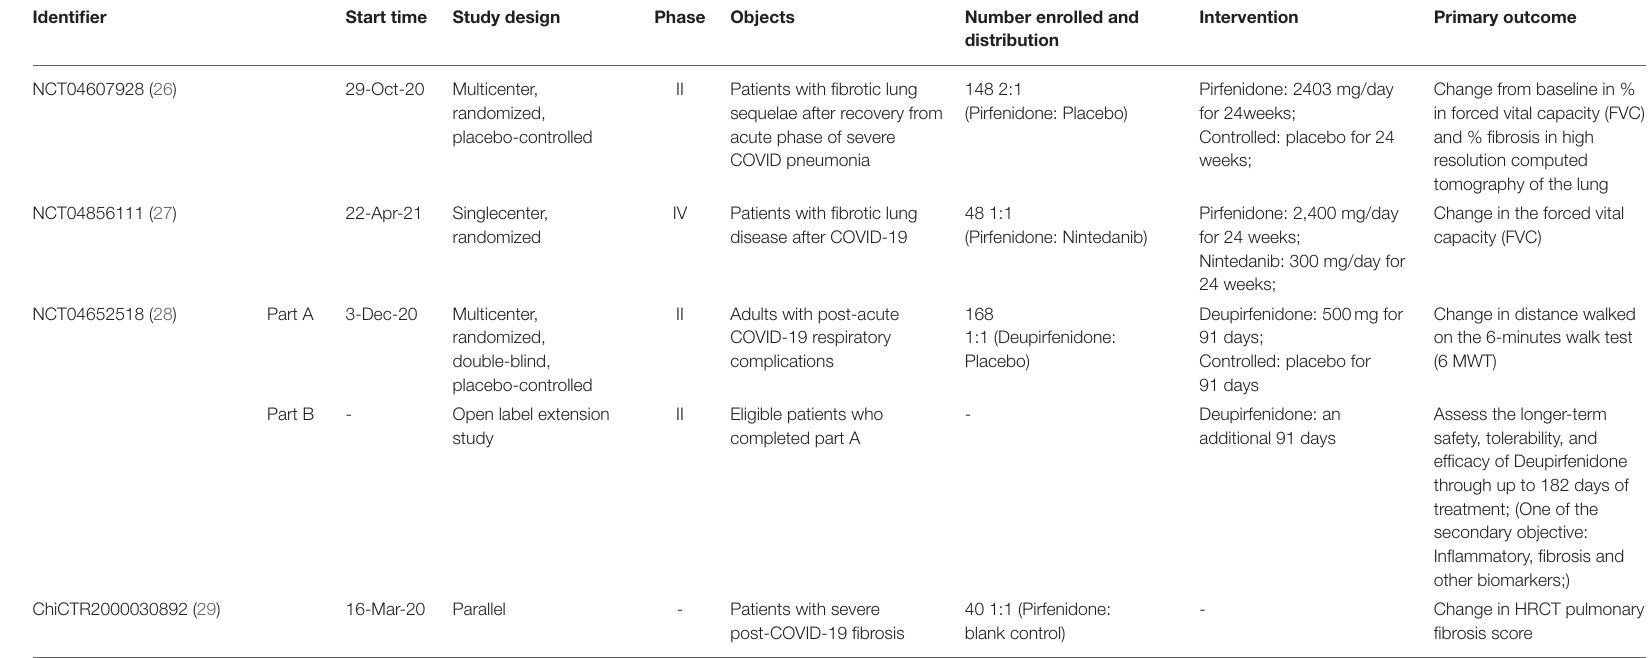
TABLE 2 | Clinical trials a of pirfenidone and deupirfenidone b for the treatment of post-COVID-19 pulmonary fibrosis.